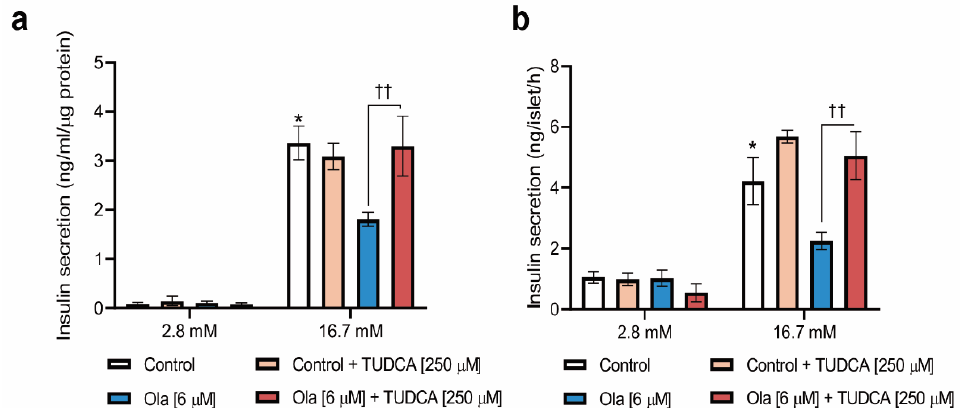
Figure 5. Restoration of insulin secretion in INS-1 cells and pancreatic islets by co-treatment with olanzapine and TUDCA. ( a ) GSIS in INS-1 beta cells co-treated with olanzapine (6 µ M) in the absence or presence of TUDCA (250 µ M) for 24 h. Data are presented as mean ± SEM of n = 3 independent experiments (3 replicates/condition), passage 25–35. ( b ) GSIS in pancreatic islets under the same experimental conditions described in ( a ). Experiments were performed in 3–4 replicates per condition in islets from n = 6 mice. p -values were determined by two-way ANOVA and Bonferroni post-hoc test. * p < 0.05, compared to INS-1 or islets treated with DMSO and stimulated with 16.7 mM glucose. †† p < 0.01, compared to INS-1 cells or islets treated with olanzapine plus TUDCA and stimulated with 16.7 mM